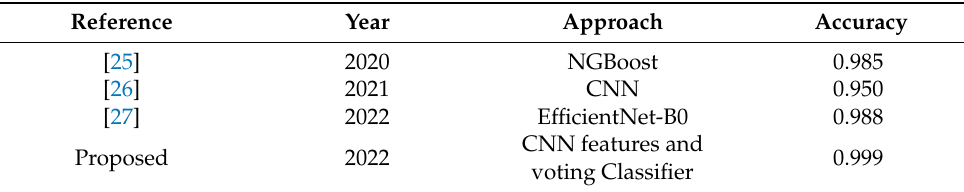
Table 5. Performance comparison with state-of-the-art